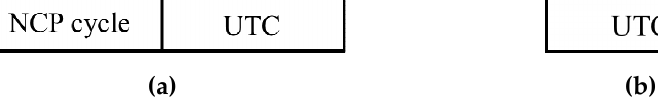
Figure 11. Addition of an NCP cycle in the data transmission structure after receiving an ADD command from the Sink Node. ( a ) Before receiving ADD command packet; ( b ) After receiving ADD command packet.